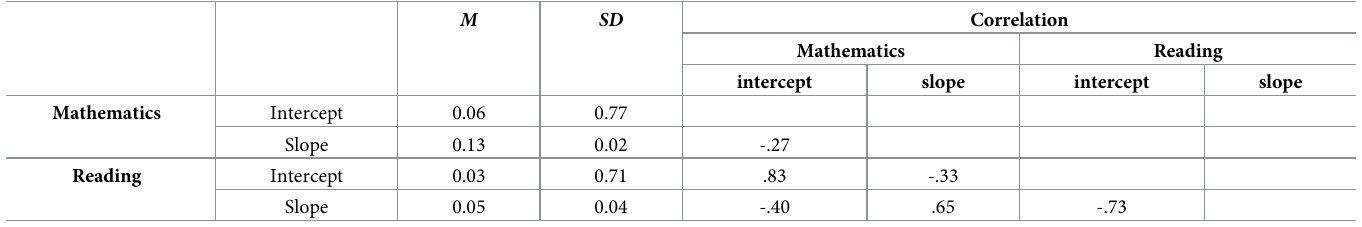
Table 4. Means, standard deviation, and correlations of the latent intercepts and